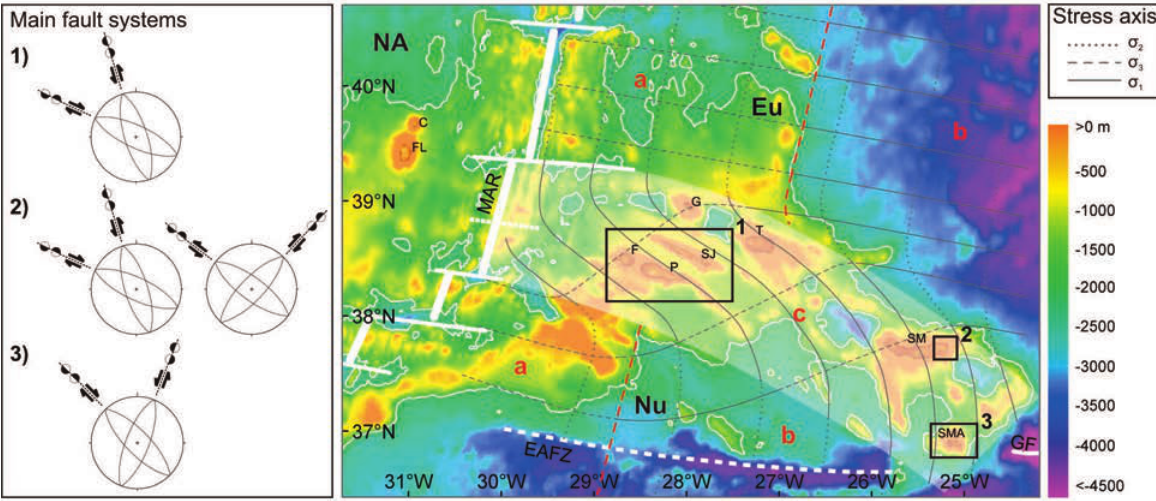
Figure 2. Stress pattern and stereographic plots of the main fault systems of the Azores region as inferred from neotectonic data [Madeira 1986, Madeira and Ribeiro 1990, Madeira 1998, Lourenço et al. 1998, Carmo 2004]. The tensile stress field (a) close to the MAR passes lat- erally to compressive (b) as the sea-floor moves away from the ridge. Inside the sheared region (c) stress permutation and deviation of stress trajectories occur. Red dashed lines separate the different stress field domains; White shaded area represents the interplate sheared region. Acronyms as in Figure 1. Bathymetry adapted from Lourenço et al. [1997]. Datum: WGS 1984 (modified from Madeira [1998], Lourenço et al. [1998] with data from Carmo